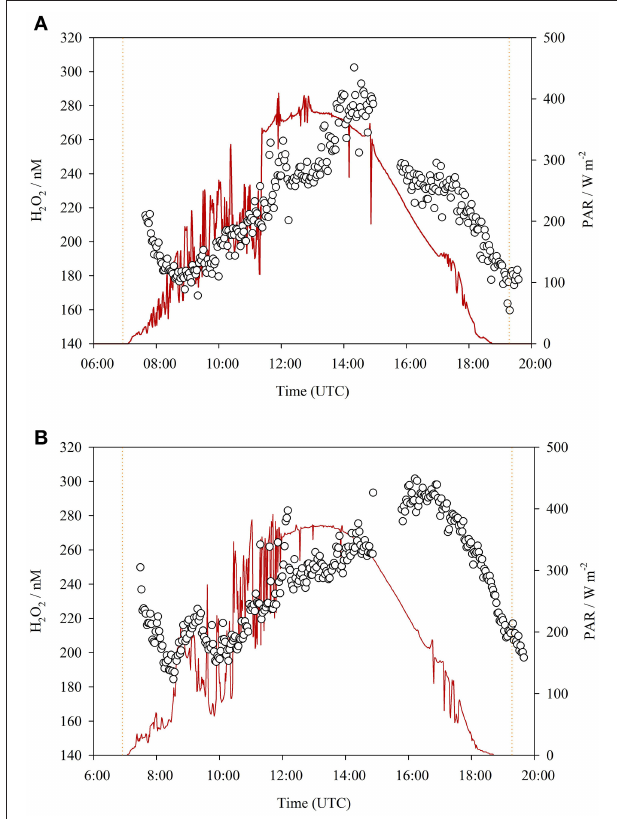
FIGURE 3 | (A) H 2 O 2 measured in mesocosm 6 (1450 µ atm pCO 2 ) surface water over a diurnal cycle (experiment day 22, 27 March 2016, sunrise 06:56, and sunset 19:17). (B) H 2 O 2 measured in mesocosm 5 (400 µ atm pCO 2 ) surface water over a diurnal cycle (experiment day 23, 28 March 2016, sunrise 06:55, and sunset 19:17). In both cases the sample line was positioned at ∼ 10cm depth. Times are UTC, sunrise/sunset refers to Las Palmas, Gran Canaria. PAR (red lines) recorded at an ELDONET site < 200m from the mesocosm jetty.